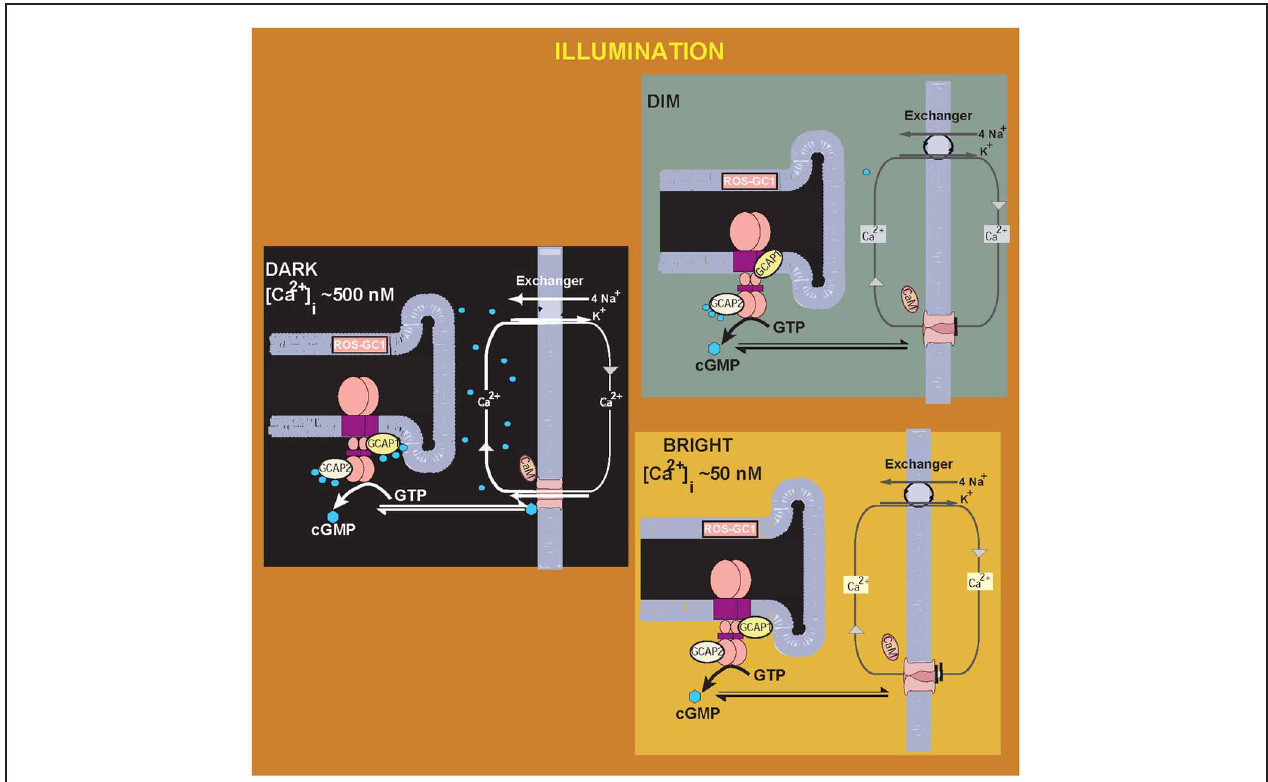
DARK to the “DIM” or intermediate LIGHT state. The initial fall of [Ca 2 + ] i is selectively detected by GCAP1, in its Ca 2 + -free state GCAP1 attains the activated mode. Transition to the “Bright” LIGHT state, the CNG channels are totally closed, both GCAP1 and GCAP2 are Ca 2 + -free and are in the activated mode, ROS-GC1 activation is full and membranes of the rod and cone outer segments are in the hyperpolarized state. [adapted and reprinted from Figure 2: with permission from Sharma